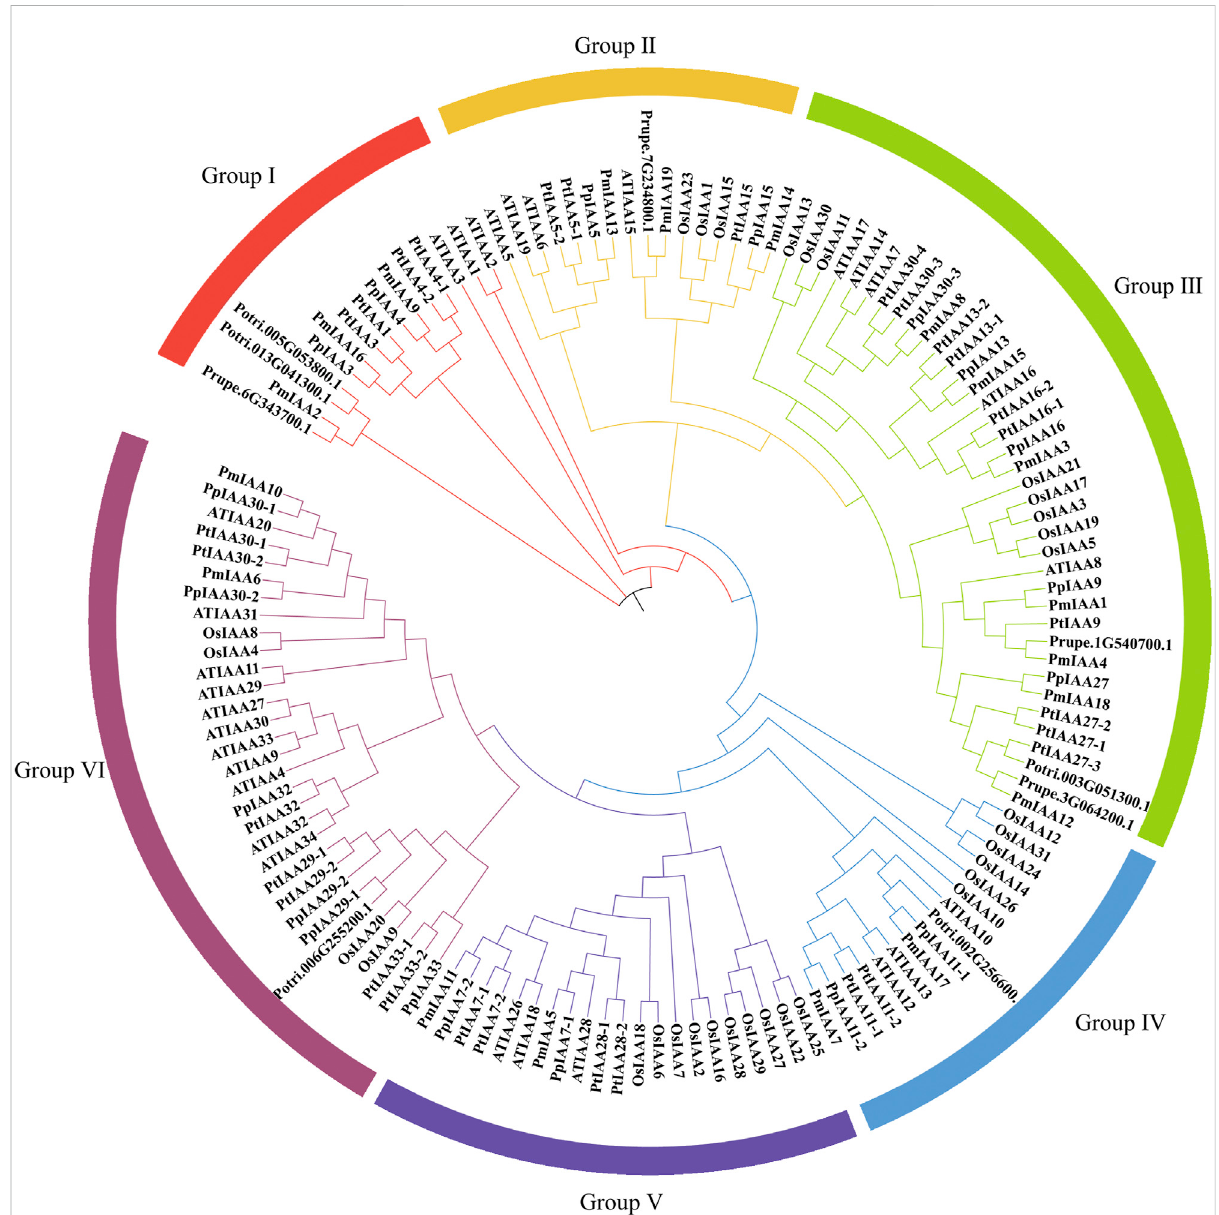
FIGURE 2 ConstructionofPhylogenetictreeforAux/IAAproteinsamongmei,peach,poplar,Arabidopsis,andrice.Proteinsequenceswerealignedbythe ClustalW and the phylogenetic tree was constructed with MEGA 11 software through the ML method. The six Aux/IAA groups ( Ⅰ – Ⅵ ) were colored